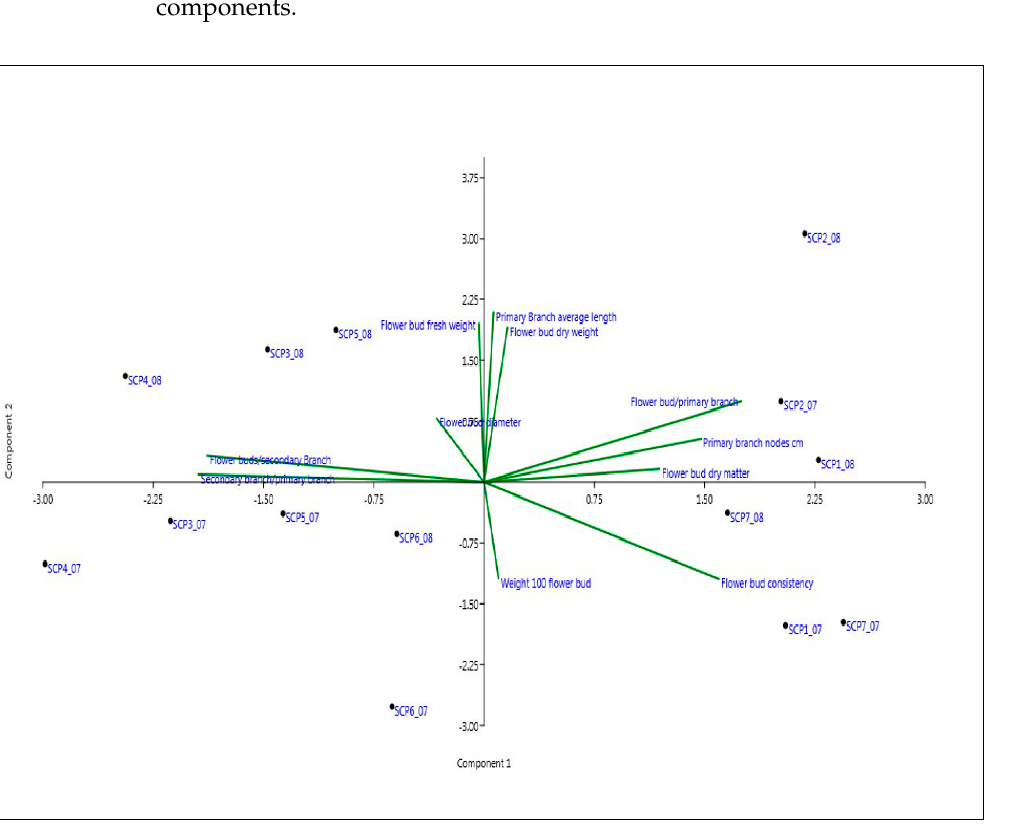
Figure 5. Distribution of the accessions on the score plot for the two principal components. In the graph, the dots refer to accessions of Capparis spinosa subsp. rupestris grown in the first year while the squares refer to accessions grown in the second year, the same color refers to the same acces- sion.